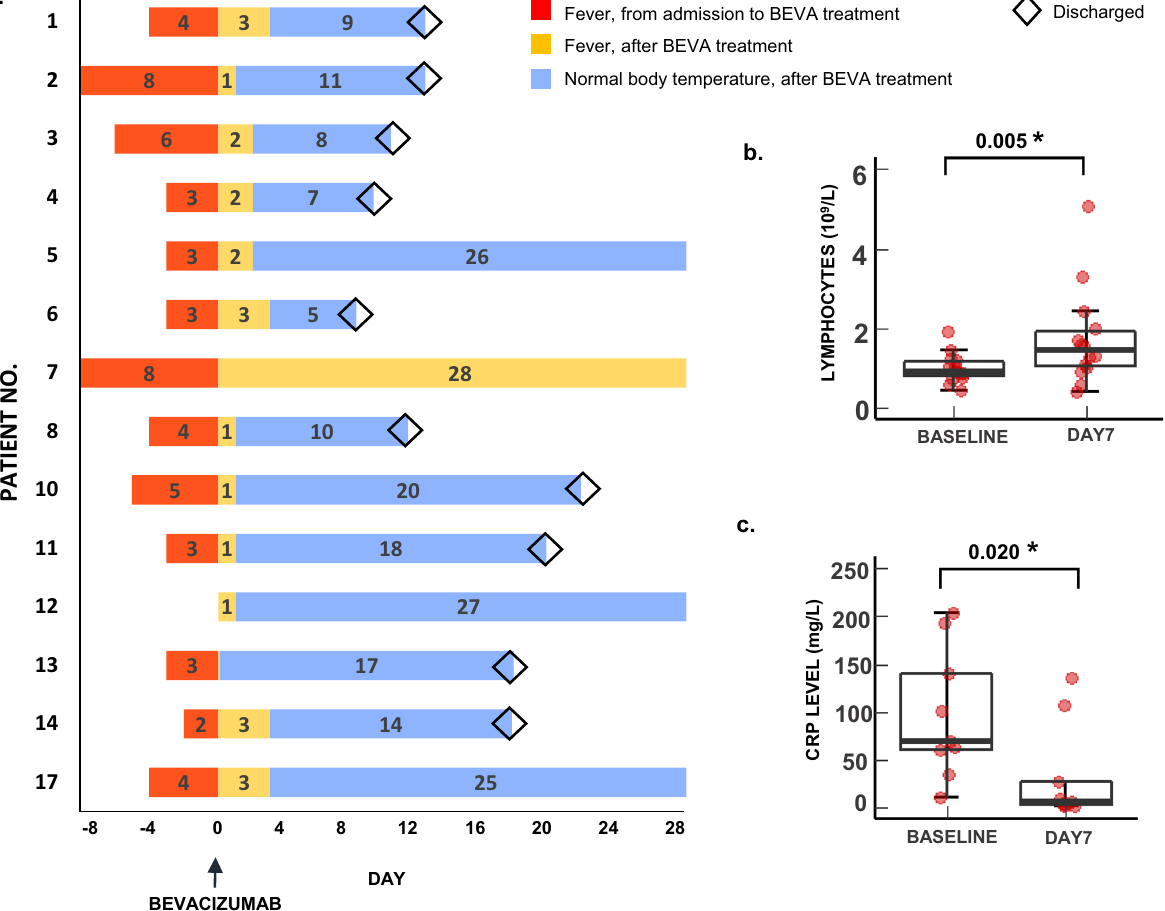
Fig. 6 Changes in fever symptom, lymphocyte counts, and in fl ammation markers of individual patients. Dynamic changes in fever status of 14 BEVA (bevacizumab)-treated patients who had a fever at enrollment ( a ). Day 0 marks the time point for initiating bevacizumab treatment; red, orange, and blue columns indicate the duration of fever or normal body temperature status before and after BEVA treatment; and diamonds represent discharge. Numbers along the vertical axis represent the patient numbers that match Fig. 2. Changes of lymphocyte counts ( n = 14) ( b ) and C-reactive protein (CRP) levels ( n = 9) ( c ) before and after BEVA treatment were analyzed by the Wilcoxon signed-rank test. The center lines of boxes represent median values; the lower and upper hinges represent the 25th and 75th percentiles (Q1 and Q3), the range between which represents the interquartile range (IQR); whiskers correspond to the highest or lowest values of non-outlier data (within 1.5 × IQR from the lower or upper hinges); numbers on the horizontal lines represent p -values. The red dots represent the data of individual treated patients. p < 0.05 for two-tailed hypothesis tests was considered statistically signi fi cant. Source data are provided as a Source Data fi le.